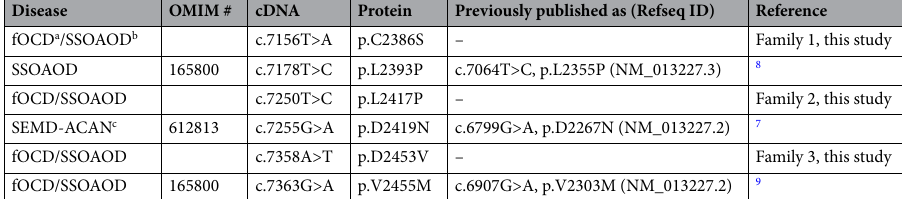
Table 1. Aggrecan G3 missense variant nomenclature. The ACAN variant cDNA and protein numbering used in the present study is based on RefSeq NM_001369268.1 (PRI 14-OCT-2019). a Familial osteochondritis dissecans with short stature and early onset osteoarthritis. Autosomal dominant inheritance. b Short stature and advanced bone age, with or without early-onset osteoarthritis and/or osteochondritis dissecans. Autosomal dominant inheritance. c Spondyloepimetaphyseal dysplasia, aggrecan type. Autosomal recessive